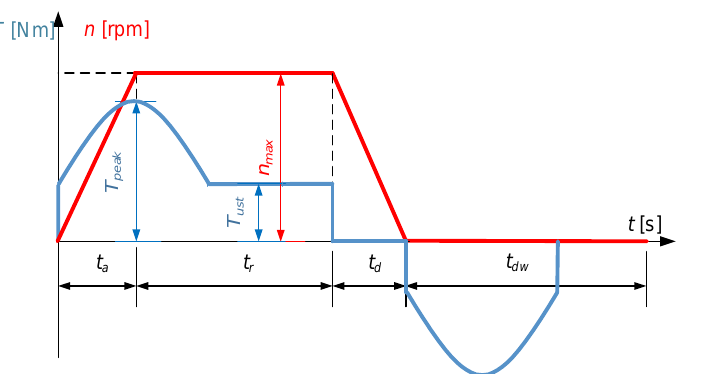
Figure 19. The set course of changes in the set speed and the resistance moment of the trolley travel drive.